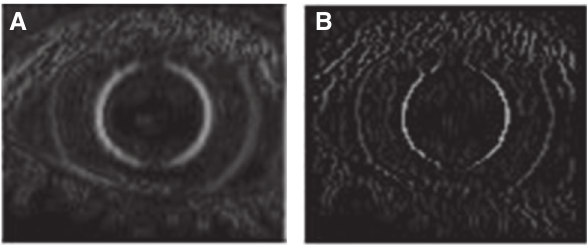
Figure 7. Relative Positions of the Eight Neighbor Points.